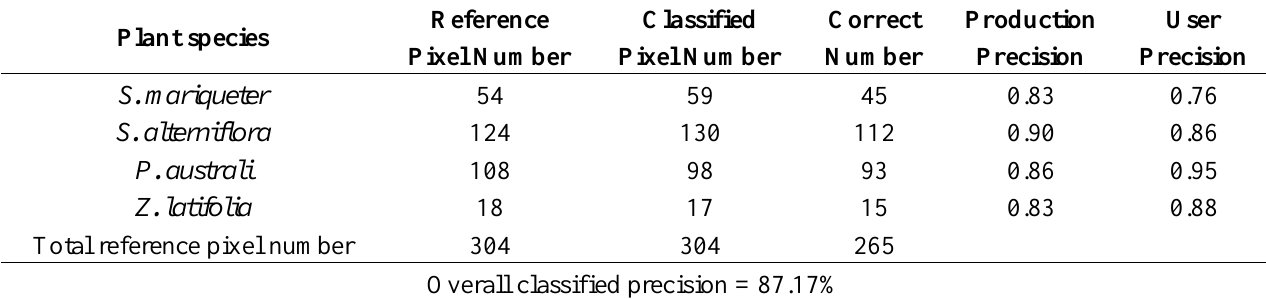
Figure 4. The classified distribution of dominant plant species at Jiuduansha Wetland in 2012. Table 4. The precision evaluations for the decision tree classification